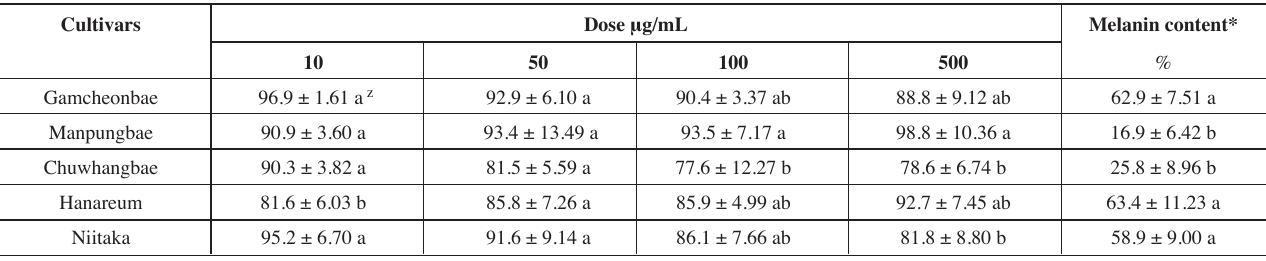
Tab. 3: Cell viability and melanin systhesis inhibition by pear ethanol